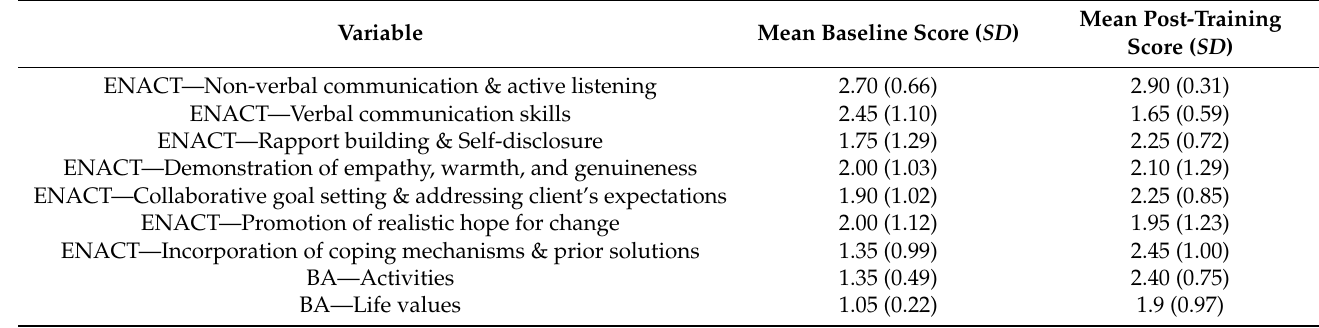
Table 3. Descriptive data on baseline and post-training skills.